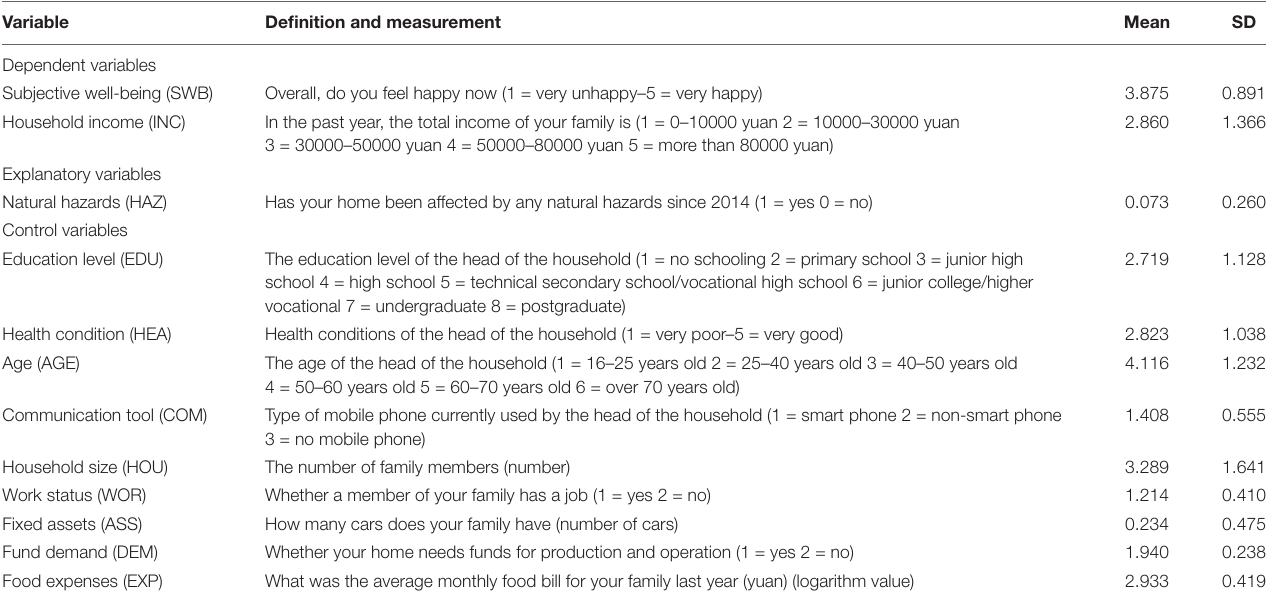
TABLE 1 | Descriptive statistics of the variables used in this